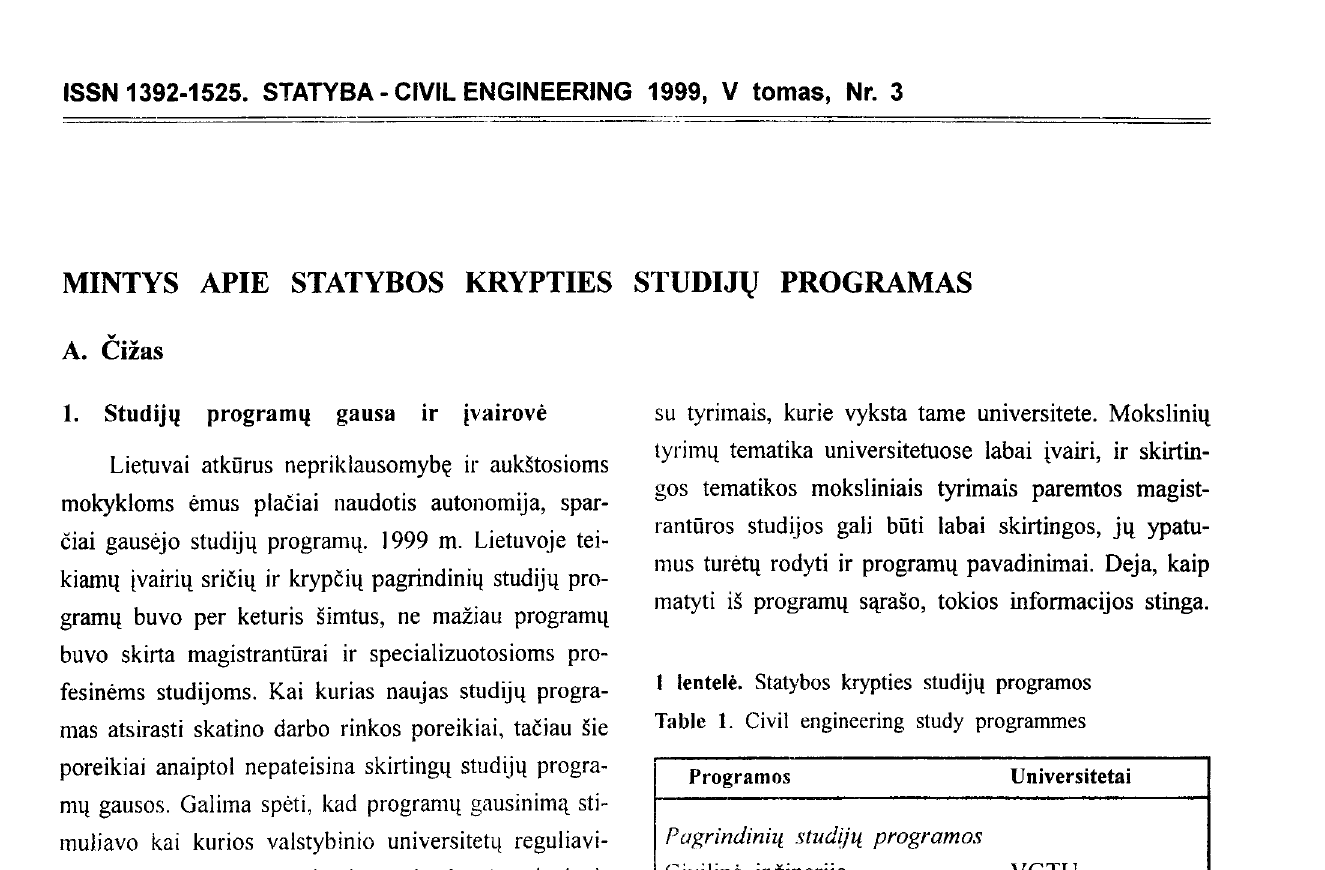
Table 1. Civil engineering study